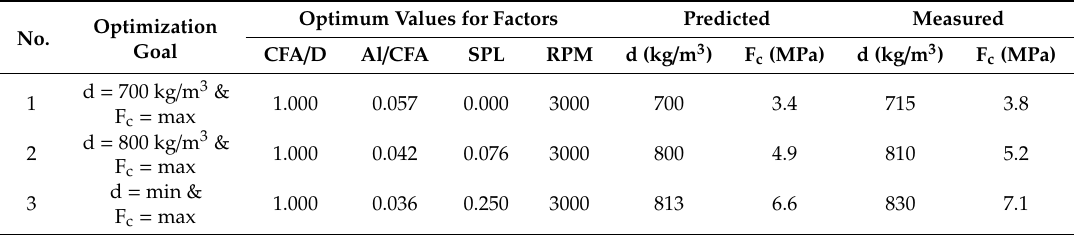
Table 6. Optimization results.